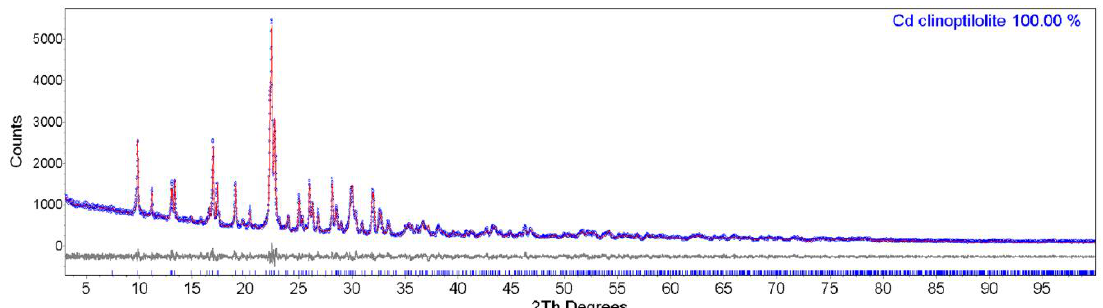
The difference powder XRD plot of sample Cd-clinoptilolite (90 °C, 22 days) after the final refinement stage is shown in Figure 3.